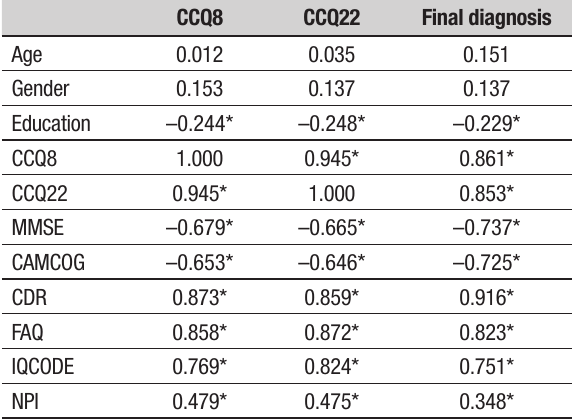
Table 4. Spearman correlation coefficients (r) among variables and CCQ8, CCQ22 and final consensus